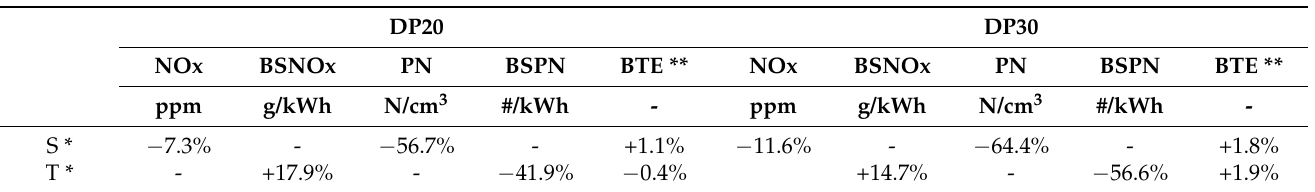
Table 7. The comparison of results of the steady-state experiment and the RDE tests of the same model of CHINA VI heavy-duty